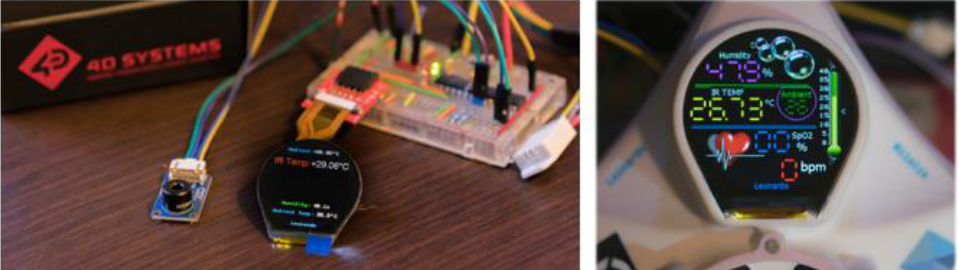
Figure 8. Photographs of the employed visual display device during testing ( left ) and assembled on the mask ( right ).